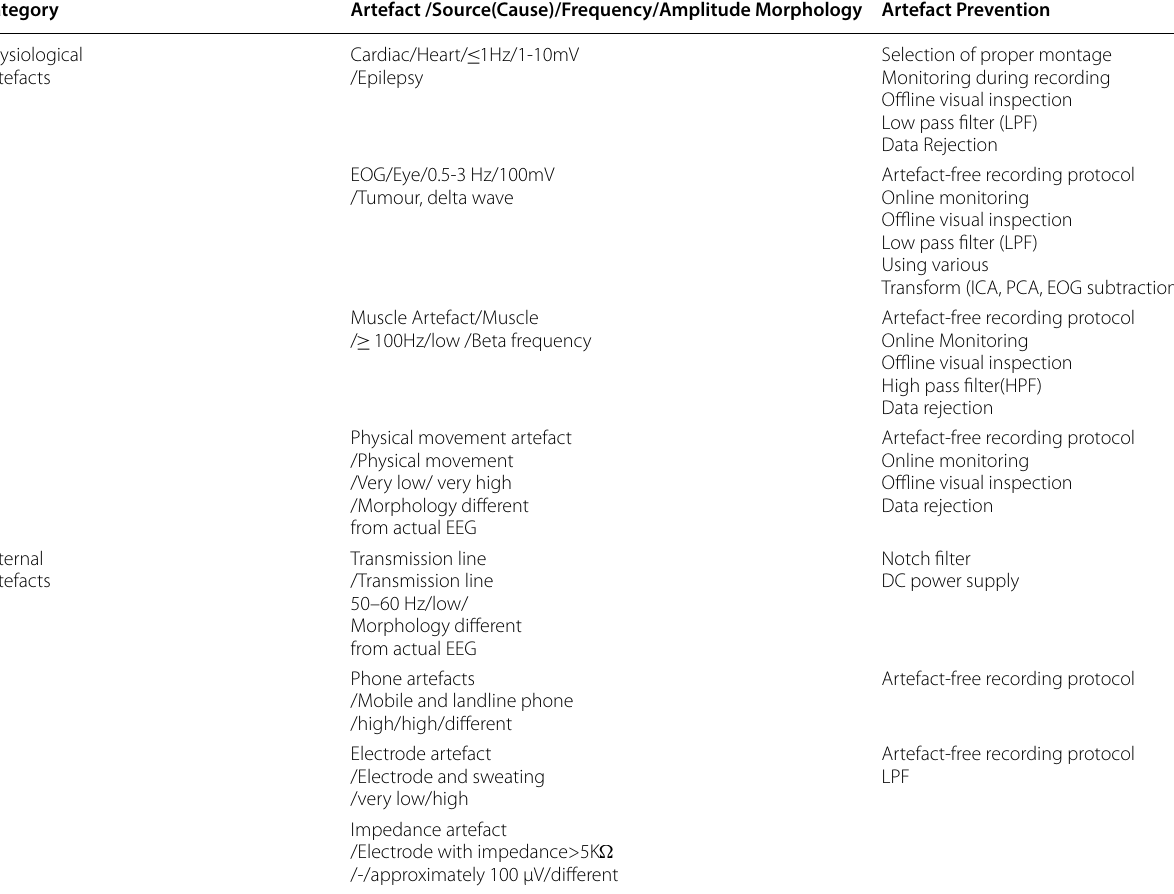
Table 9 Various artefacts in EEG signal recording